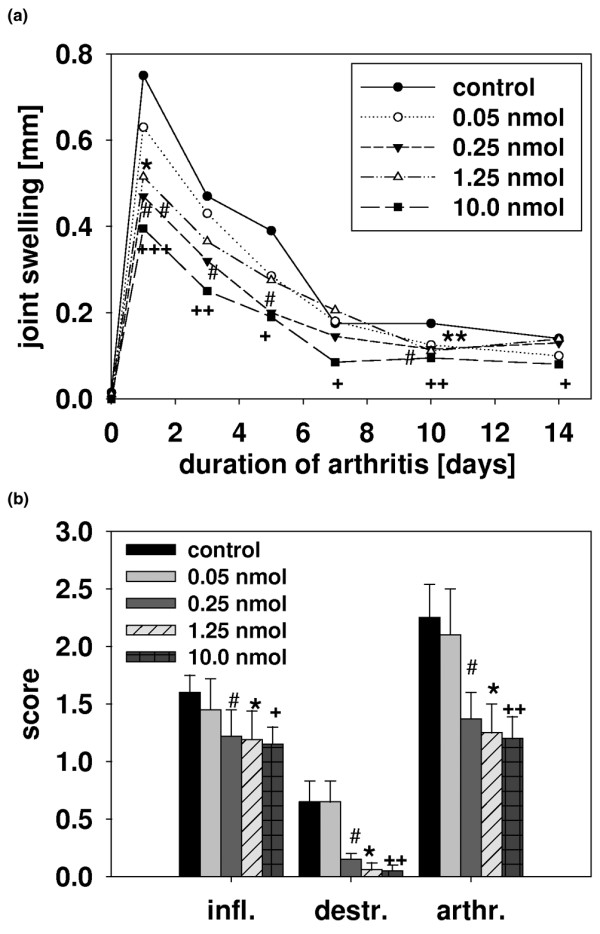
Dose-dependent therapeutic effects of the STAT-1 decoy oligodeoxynucleotide (ODN) on antigen-induced arthritis (AIA). Arthritis was induced in the right knee joint at day 0, 4 h after application of the decoy ODN. (a) Effects of the STAT-1 decoy ODN treatment on joint swelling. Joint swelling was assessed as the difference between right (arthritic) and left (untreated) knee joint diameter. (b) Histological evaluation of arthritis (day 14 of AIA). Hematoxylin-eosin stained knee sections were evaluated blindly by grading of inflammation (infl.; cell exudate or infiltrate, hyperplasia) and joint destruction (destr.; necrosis, erosion and pannus formation). Total arthritis score (arthr.) is defined as the sum of the inflammation and destruction scores. Each ODN dose represents n = 10;#P ≤ 0.05, ##P ≤ 0.01 (0.25 nmol versus buffer-treated AIA control); *P ≤ 0.05, **P ≤ 0.01, (1.25 nmol versus buffer-treated AIA control); +P ≤ 0.05, ++P ≤ 0.01, +++P ≤ 0.001 (10 nmol versus buffer-treated AIA control).